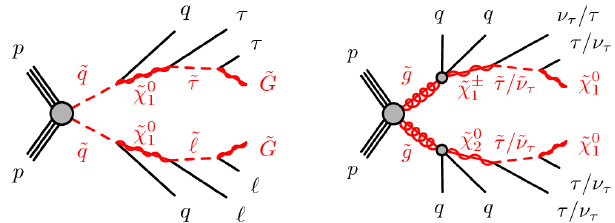
Figure 1: Diagrams illustrating example processes of the GMSB model (left), the scalar lepton ˜ l is preferentially a ˜ τ for high values of tan β , and the simplified model 1 (right) [ 4 ] .